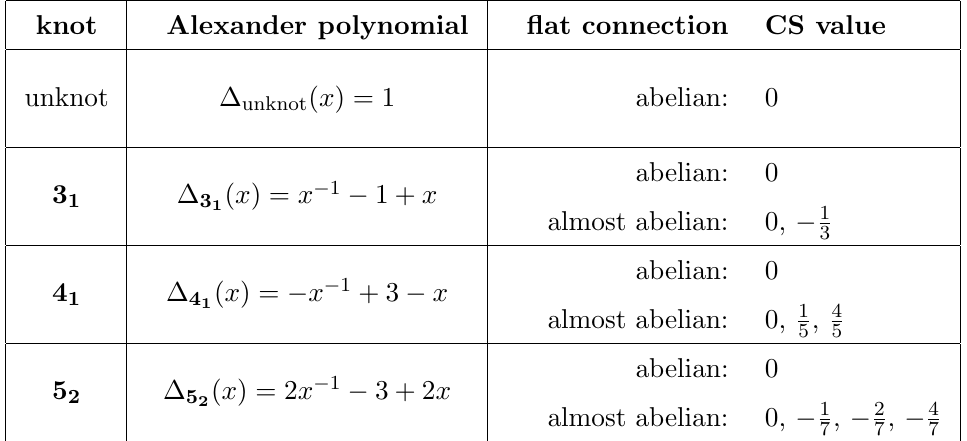
Figure 6 . The 5 2 knot.